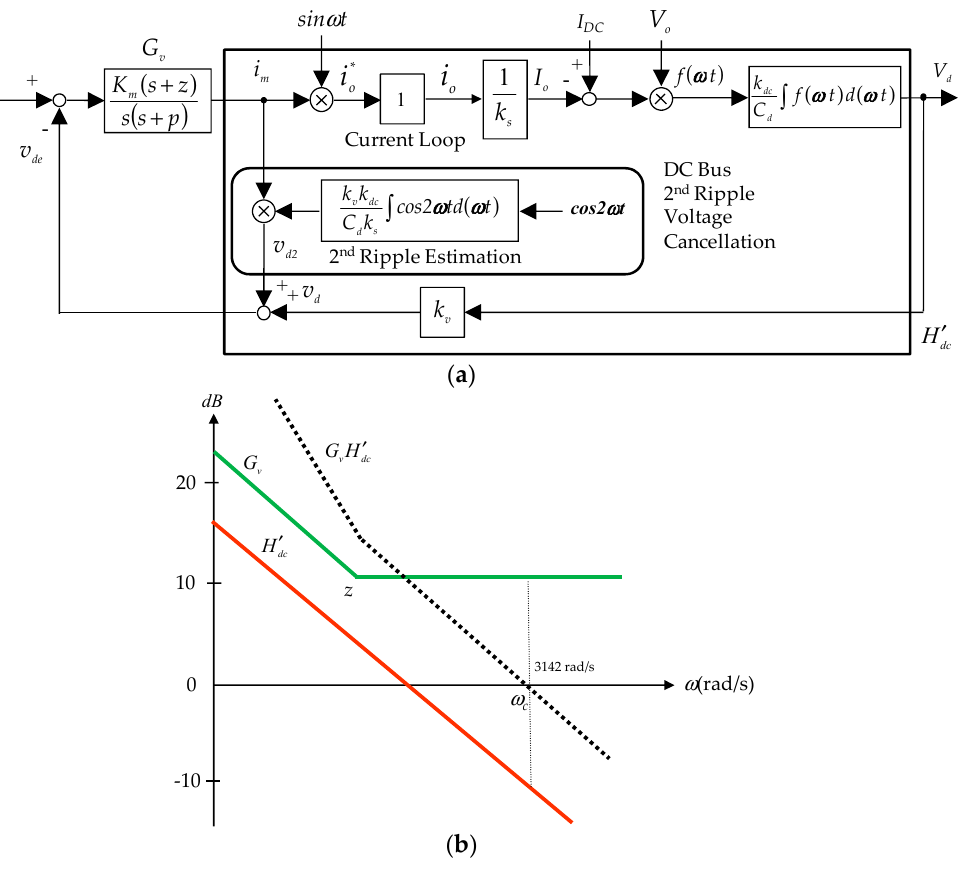
Figure 4. Proposed method for cancellation of 2nd ripple voltage on the DC bus: ( a ) Control block diagram; ( b ) Bode plot of control loop transfer functions.